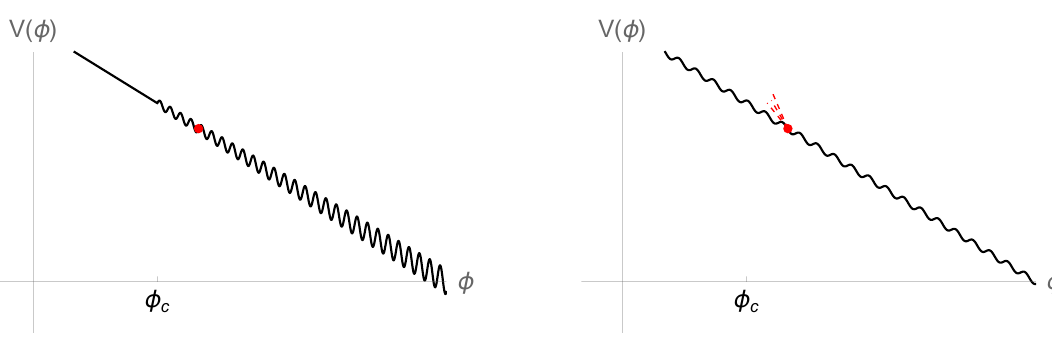
Figure 1 . Cartoon sketch of the relaxion potential in the model with a vev-dependent periodic potential (left) and with particle production (right). The vev-dependent periodic potential height grows linearly or quadratically with φ after passing the critical point φ relaxion as shown by the red point. In the particle production mechanism, particle production is triggered after the critical point, indicated by dashed red lines, which introduces extra friction to trap the